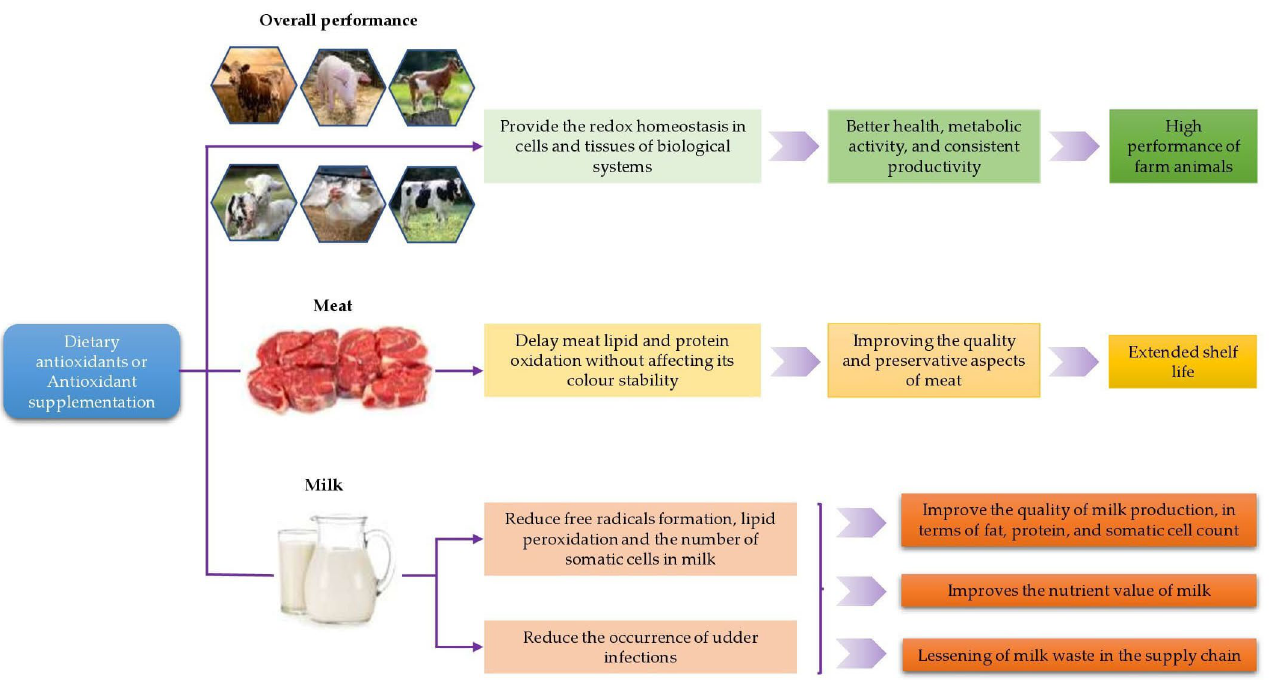
Figure 10. Impact of dietary antioxidants or antioxidants supplementation on the overall performance and meat and milk production of farm animals. The schematic diagram shows how diets rich in antioxidants can enhance animal productivity and improve quality and preservative aspects of meat and milk in farm animals.